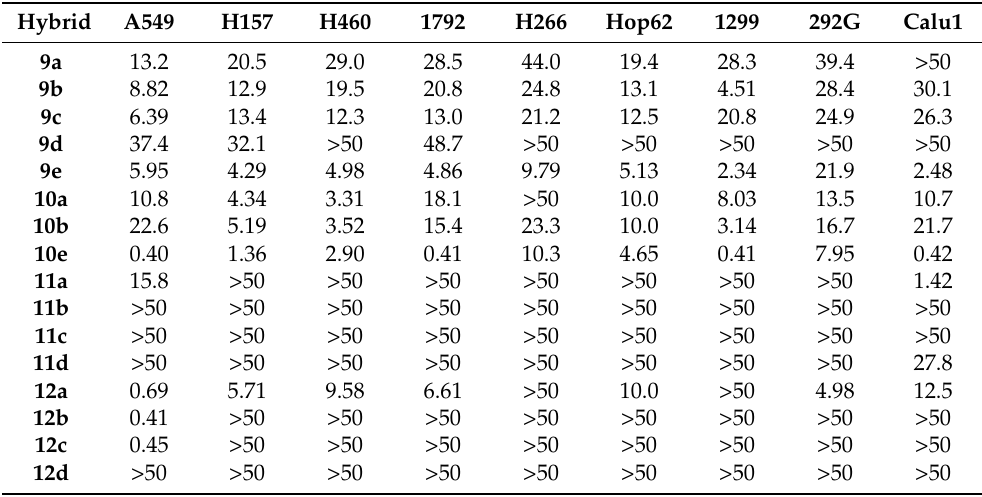
Table 1. The in vitro anticancer activities of the hybrid nitrates 9 – 12 in nine human lung cancer cell lines (IC 50 in µ M)